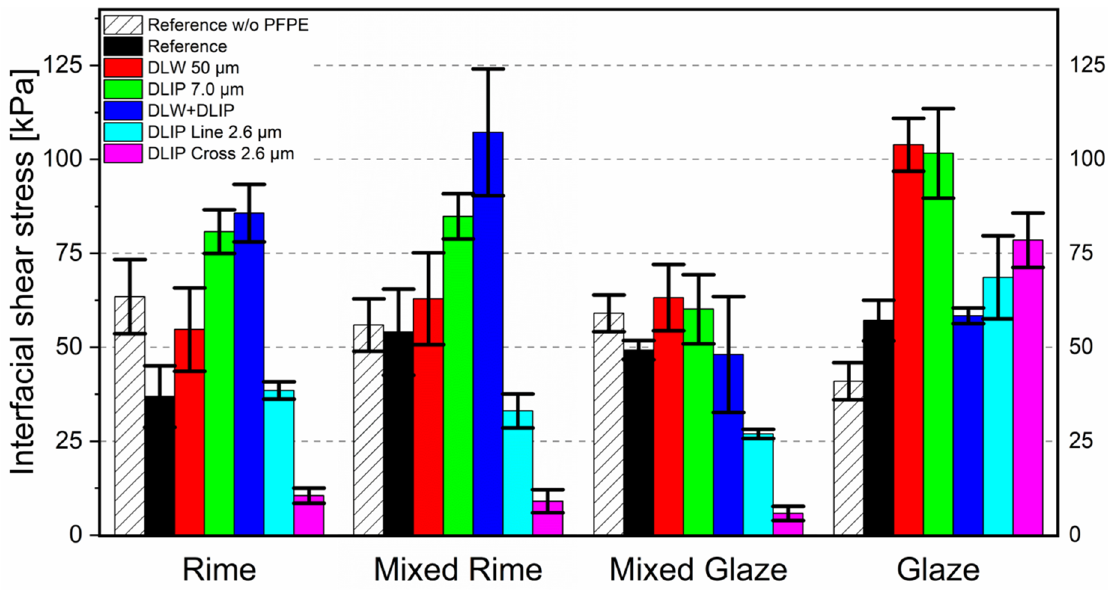
Figure 5. Histograms depicting the results of the ice adhesion tests for the four different ice conditions of rime, mixed rime, mixed glaze, and glaze with the interfacial shear stress for the five laser-structured specimens, a reference, and a PFPE untreated (w/o PFPE) reference.